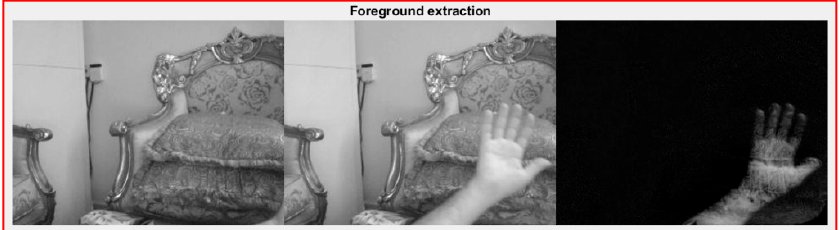
Figure 7. Example on appearance recognition using foreground extraction in order to segment only ROI, where the object features can be extracted using different techniques such as pattern or image subtraction and foreground and background segmentation algorithms.